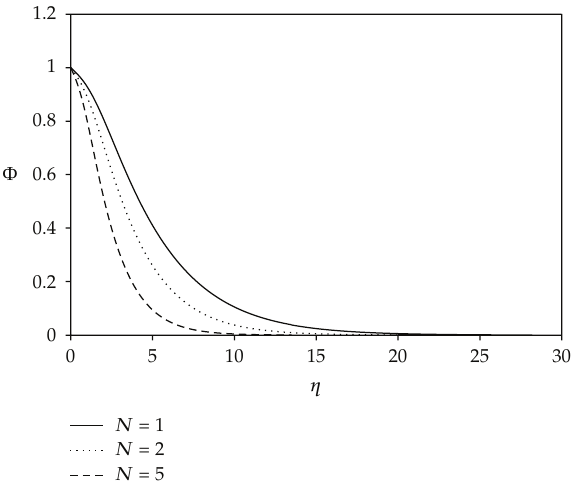
Figure 9: Concentration profile for di ff erent values of N for Du (cid:8) 0 . 03, Sr (cid:8) 2, θ r (cid:8) 5, Le (cid:8) 0 . 1, Pr (cid:8) 0 . 71, and Sc (cid:8) 0 .